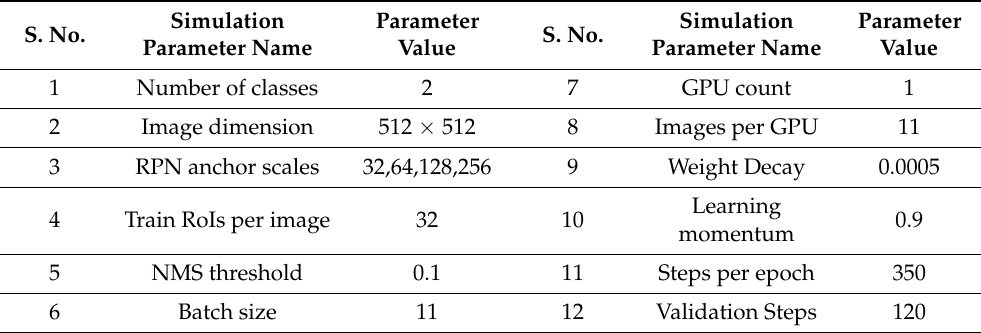
Table 5. Experimental parameter